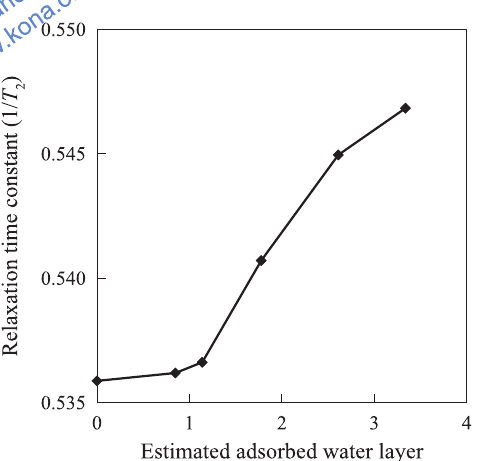
Fig. 6 Relationship between R sp and total surface area of Aerosil130.